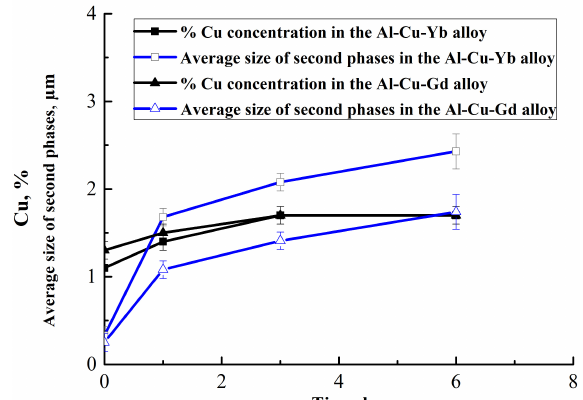
Figure 6. Average size of second phases and copper concentration in the solid solution depends on the homogenization time.